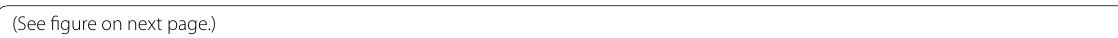
Fig. 3 Restored miR-499-5p or depleted Sox6 reduces TUNEL positive cells, Caspase-3 and Caspase-9 protein expression in lung tissues of sepsis-induced lung injury mice. a TUNEL positive cells in lung tissues of mice. b Number of TUNEL positive cells in lung tissues of mice. c Immunohistochemistry of Caspase-3 and Caspase-9 in lung tissue of mice; d Mean OD value of Caspase-3 and Caspase-9 in lung tissue of mice. e Protein bands of Caspase-3 and Caspase-9 in lung tissues of mice. f Caspase-3 and Caspase-9 protein expression in lung tissues of mice in each group. (a) P < 0.05 versus the sham group. (b) P < 0.05 versus the agomir NC group. (c) P < 0.05 versus the si-NC group. (d) P < 0.05 versus the miR-499-5p agomir oe-NC group. Measurement data were depicted as mean standard deviation, and data were assessed by one-way ANOVA + ± followed by Tukey’s post